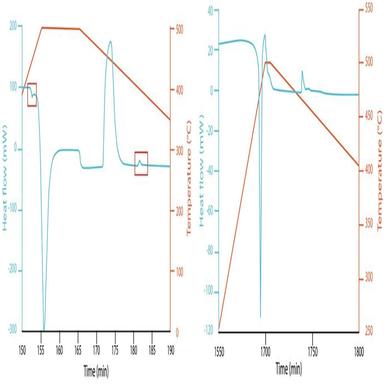
LiOH underwent 6 thermal cycles: Here on the left, third LiOH thermogram obtained at a heating scanning rate of 0.3 °C/s. The red frames show the LiOH softening. On the right, the third thermogram obtained for a heating scanning rate of 0.1 °C/s. The same palier of 5 min at 500 °C has been applied for both protocols.